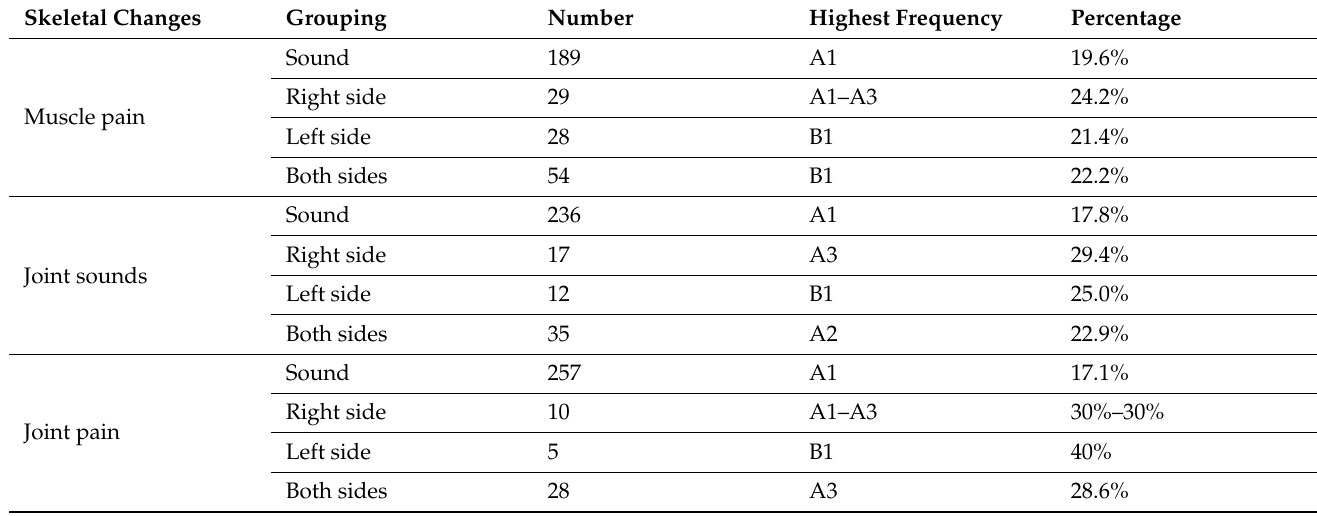
Table 2. Frequency of condylar changes detected on panoramic radiographs based on the Eichner’s